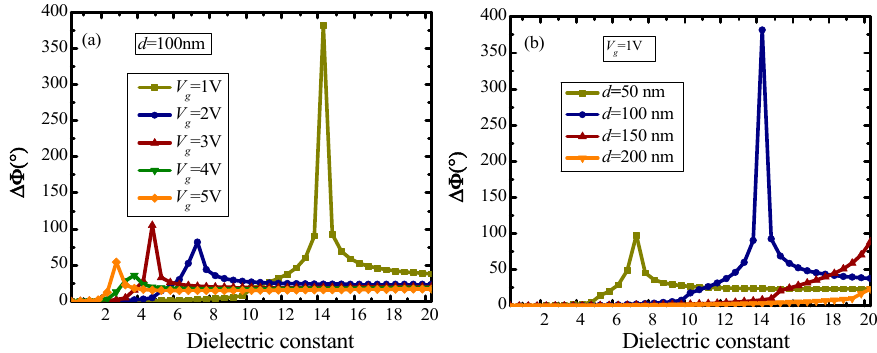
Figure 7. Dependence of the dielectric constant of HfAlO x on the phase shift: ( a ) given different v g ; ( b ) given different d .